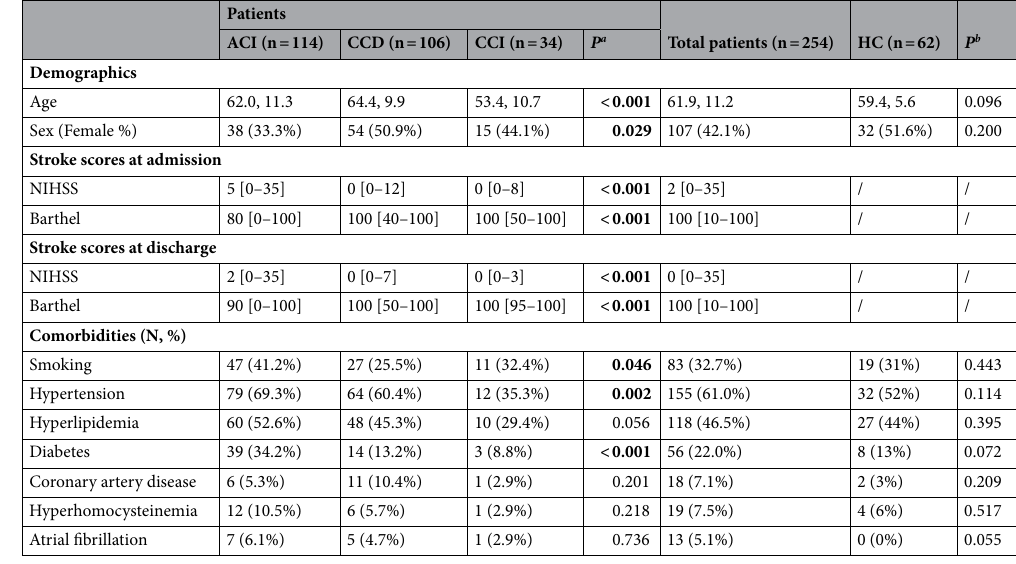
Table 1. Characteristics of the study cohort. Significant values are in bold. P a : P values from comparisons among 3 groups of ischemic patients. P b : P values from comparisons of all patients and the healthy control group. Data were presented as mean, SD, or median [range]. ACI acute cerebral infarction, CCD chronic cerebrovascular disease, CCI chronic cerebral circulation insufficiency, HC healthy control, NIHSS National Institutes of Health Stroke